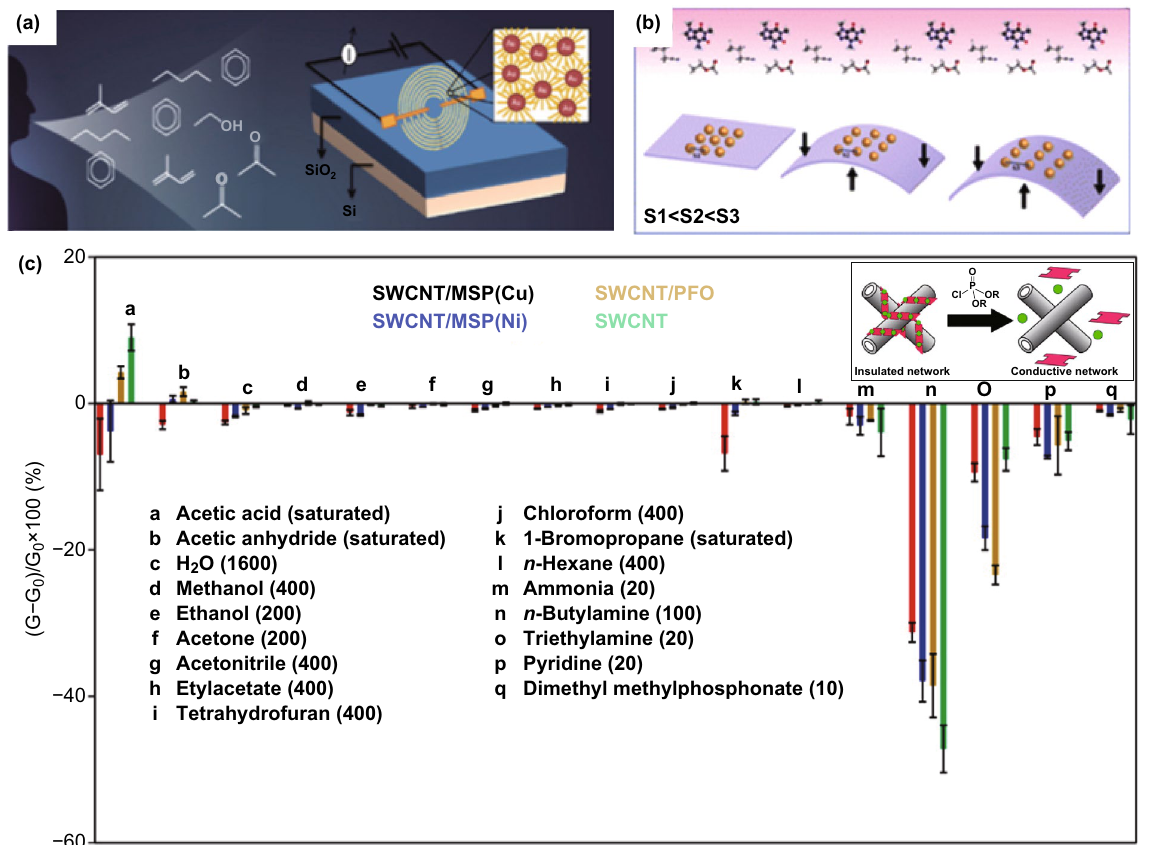
Fig. 10 a Schema of the working principles of gold NPs thiol-coated thiols gas sensor. Reproduced with permission [81]. Copyright 2014, Else- vier. b Schema of a strain regulated gold NPs-based gas sensor. Reproduce with permission [112] . Copyright 2015, American Chemical Society. c Response of SWCNT-based chemi-resistive sensors after 50-s exposure to different vapors in N 2 (concentration in ppm in parentheses). The inset is the schema of the working mechanism. Reproduced with permission [80]. Copyright 2015, American Chemical